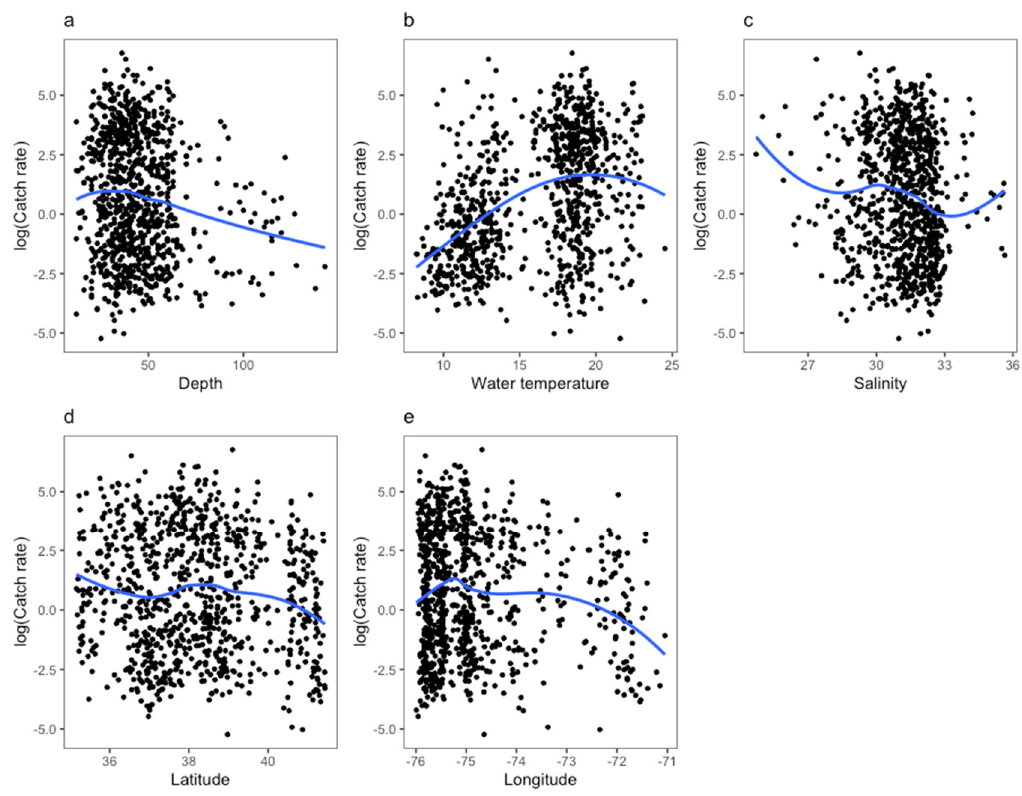
Figure 7. Catch rate (log-transformed) versus environmental variables by smoothing function (( a ) depth; ( b ) water temperature; ( c ) salinity; ( d ) latitude; ( e ) longitude).